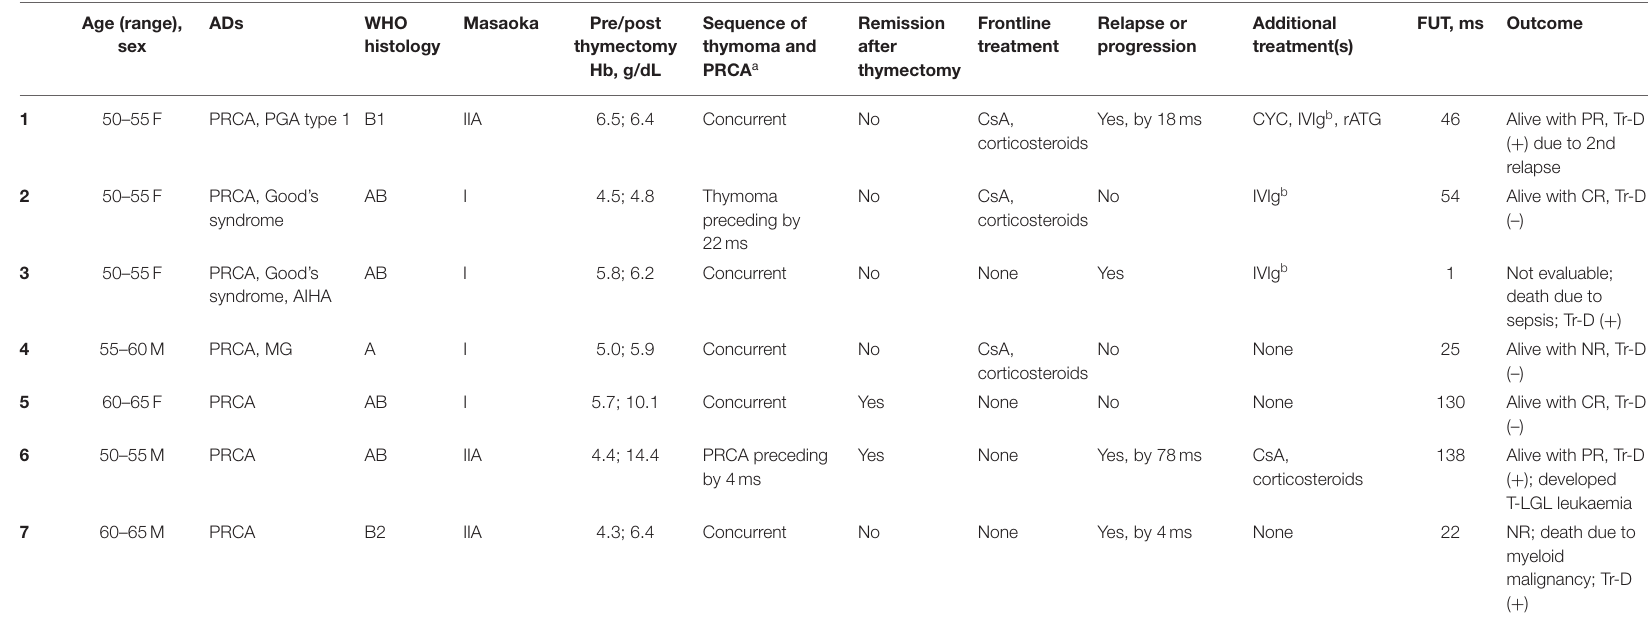
a Concurrent: the time interval between diagnosis of thymoma and PRCA equivalent or < 3 months. b IVIg administration as a prophylactic treatment for hypogammaglobulinaemia. PRCA, pure red cell aplasia; FUT, follow-up time; AIHA, autoimmune haemolytic anaemia; ADs, autoimmune diseases; Hb, haemoglobin; ms, months; CR, complete remission; PR, partial remission; NR, none remission; Tr-D, transfusion dependence; PGA, autoimmune polyglandular syndrome; CsA, cyclosporin A; CYC, cyclophosphamide; IVIg, intravenous immunoglobin; rATG, rabbit anti-human thymocyte globulin; T-LGL, T cell-large granular